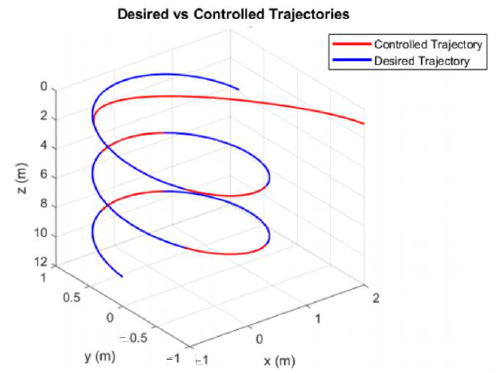
Figure 6. Simulated three-dimensional trajectory of the BlueROV2 with 𝑡 𝑏 = 5 s .